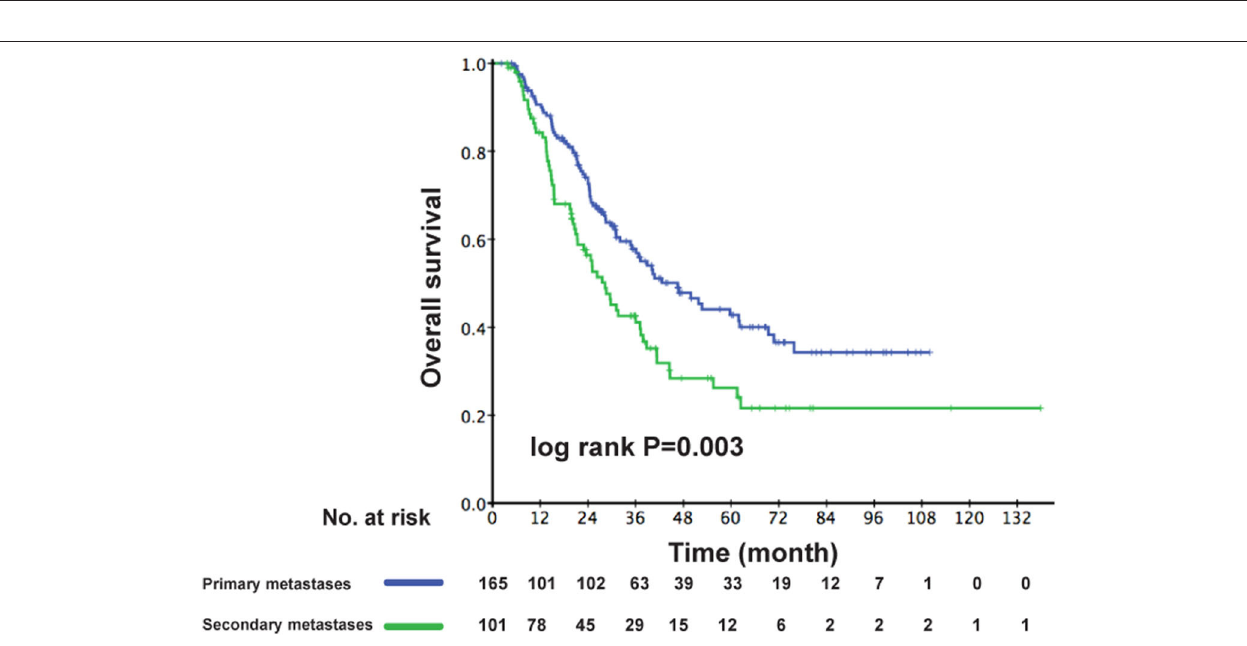
FIGURE 3 | The time-dependent 3-year ROC curve (A) . Kaplan–Meier OS curves for the metastatic patients in different EBV DNA level (B) . One hundred fifty-two patients with follow-up information of more than 3 years were involved in the ROC analysis.